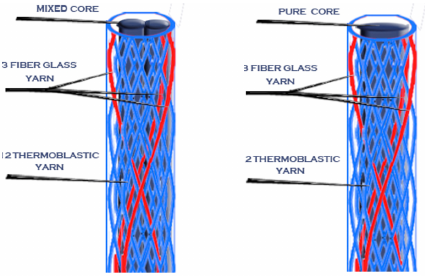
Figure 3. Sample 1 with different